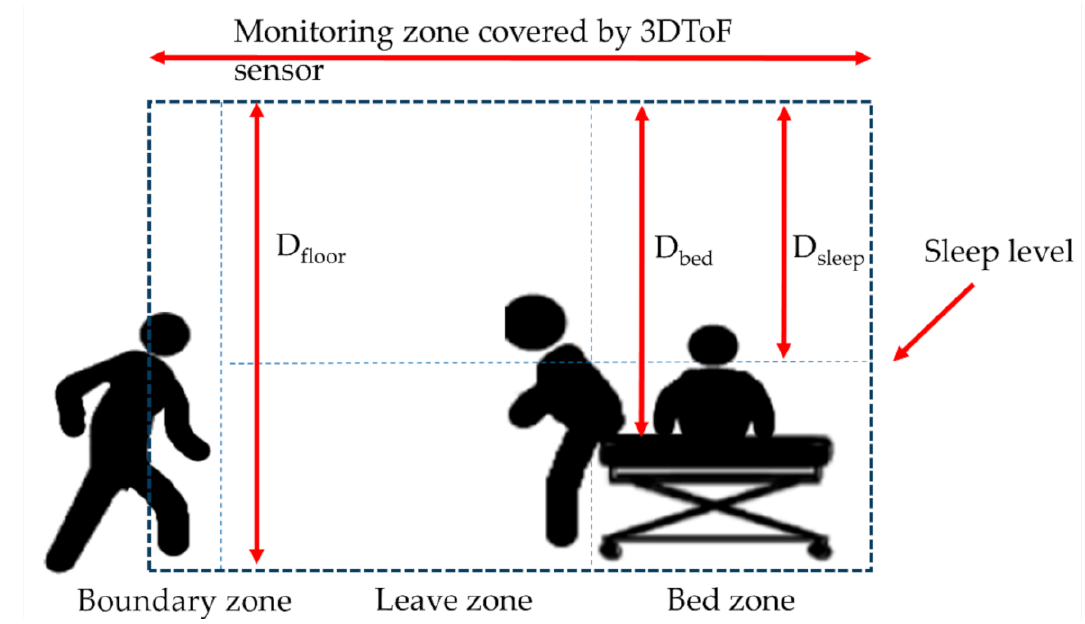
Figure 3. Main parameters used in eNightLog monitoring